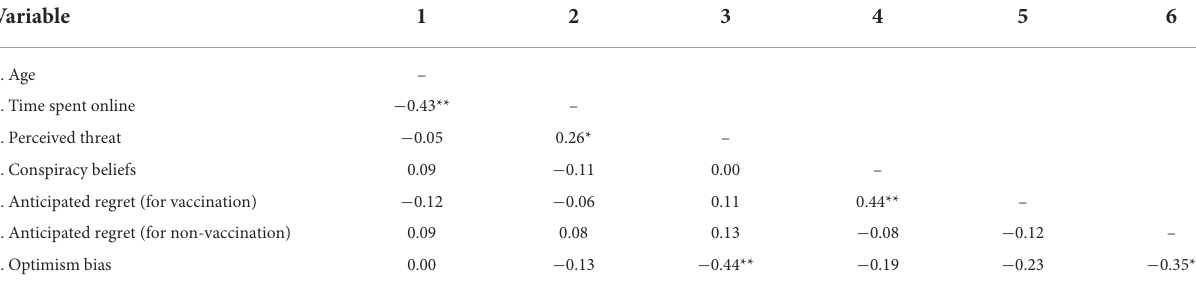
TABLE 2b Associations between the main variables ( N = 59, participants who consider the possibility of vaccinating against COVID-19). Variable